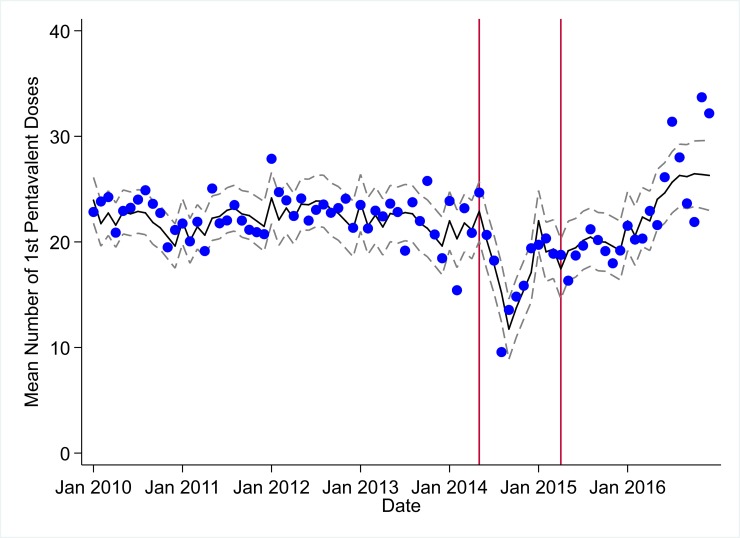
Mean trends and system losses due to Ebola virus disease (EVD) outbreak (June 2014–April 2015) for first pentavalent vaccinations in a census of 379 clinics providing services in Liberia from 2010–2016, excluding Montserrado County.The black solid line represents the fitted mean from a linear mixed model using a segmented regression parameterization, random intercepts and slopes by facility, monthly indicator variables to adjust for seasonality, a fixed effect to adjust for clinic-level catchment area, and an AR(1) structure to account for autocorrelation in residual errors. Gray dashed lines are 95% confidence intervals around the fitted mean. Red lines are placed at the final month before the start (May 2014) and end (April 2015) of the EVD outbreak in Liberia.